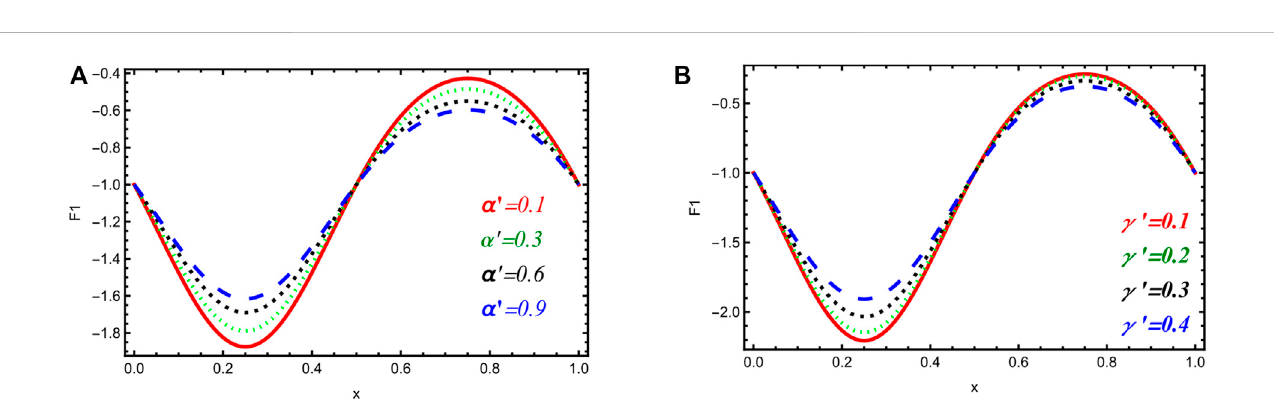
FIGURE 3 (A) represents the various values of α ′ on F 1 when M , C , γ ′ (cid:2) 0 . 1. (B) represents the various values of γ ′ on F 1 when M , C , (cid:2) 0 . 1 , α ′ (cid:2) 1 .